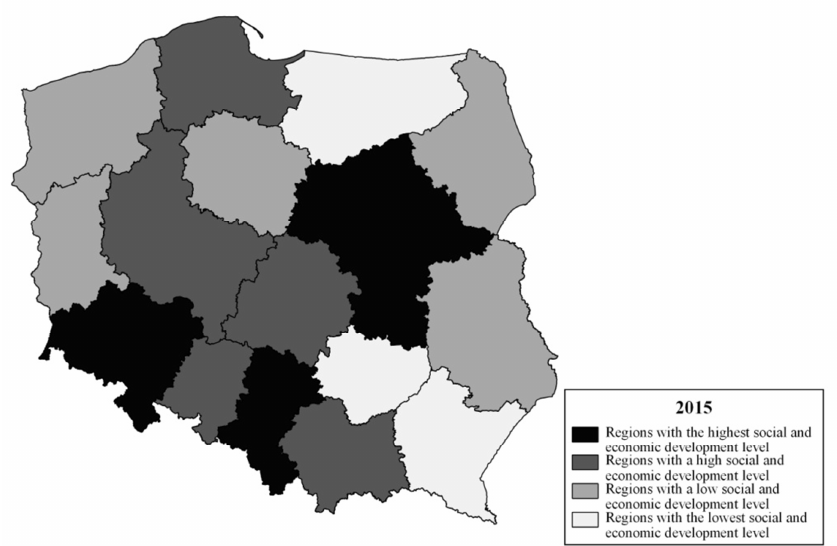
Source: own study on the basis of data from Table